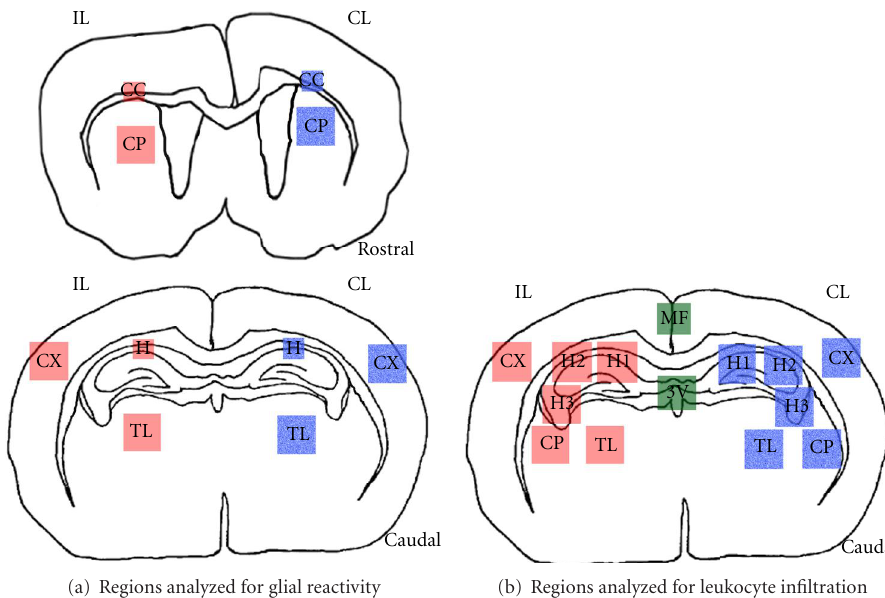
Figure 1: Drawings modified in Adobe Photoshop CS showing brain areas analyzed for quantification of di ff erent antibodies used in the study. (a) Regions analyzed for quantification of glial reactivity in rostral and caudal side of the brain (see Section 2 for details). (b) Regions analyzed for quantification of leukocyte infiltration. The regions in red are from the ipsilateral (IL) side and the regions in blue are from the contralateral (CL) side while the medial regions are shown in green. CC: corpus callosum; CP: caudate-putamen; CX: cortex; H: hippocampus; MF: medial fissure; TL: thalamus; 3V: third